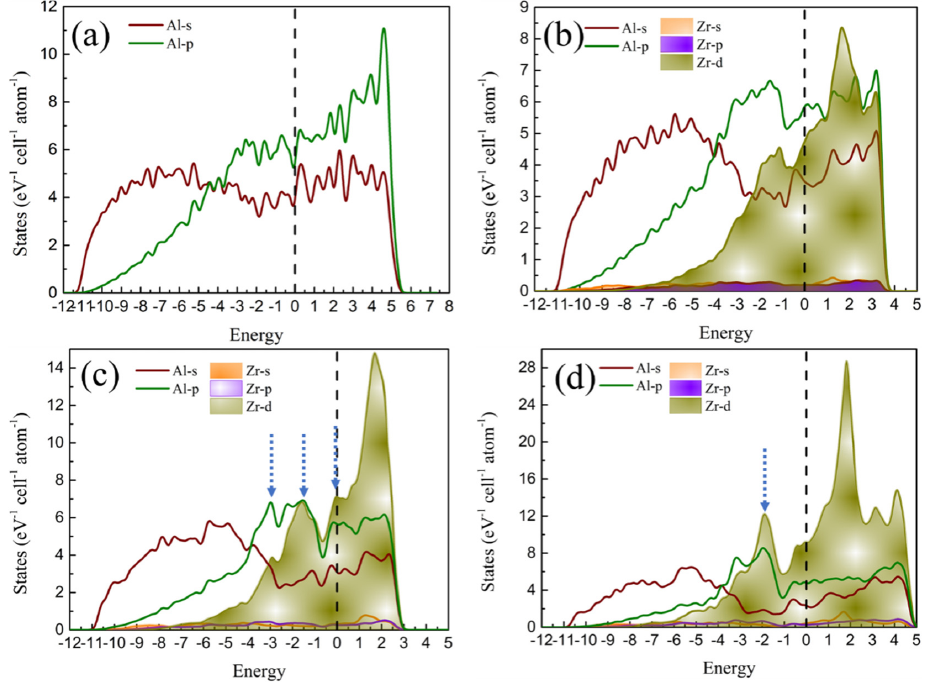
Figure 9. The projected density of state (PDOS) of the solute atoms Zr and surrounding host atoms Al. ( a ) The host Al atoms for the pure Al, ( b ) the solute atoms Zr and surrounding host Al atoms for the Al supercells with the chemical short ‐ range ordering clusters L1 2 ‐ Al 3 Zr of the volume fraction of 1/27, ( c ) the solute atoms Zr and nearest host Al atoms for the Al supercells with the chemical short ‐ range ordering clusters L1 2 ‐ Al 3 Zr of the volume fraction of 3/27 and ( d ) the solute atoms Zr and nearest host Al atoms for the Al supercells with the chemical short ‐ range ordering clusters L1 2 ‐ Al 3 Zr of the volume fraction of 9/27. The Fermi level is set as zero (the Fermi level is presented by the vertical dashed line). 4. Conclusions In conclusion, in the present work, the mechanical properties of the Al solid solution with varied compositions of the solute atoms Zr and the Al supercells with the chemical short ‐ range ordering structures L1 2 ‐ Al 3 Zr were evaluated using first ‐ principle calcula ‐ tions. Firstly, the supercells of the solid solution with varied compositions of the solute atoms Zr were constructed by using special quasirandom structures (SQSs). Next, the Al supercells with the chemical short ‐ range ordering structures L1 2 ‐ Al 3 Zr were obtained by substituting the Al atoms with the Zr atoms. Then, the bulk modulus B , shear modulus G , Young’s modulus E , Poisson’s ratio ν , hardness H and Pugh ratio B / G of the polycrystal were calculated to investigate the elastic property below a specific stress. Finally, the ideal tensile strength was investigated by conducting the first ‐ principles tensile test. In addi ‐ tion, the deformation charge density, electron localization function (ELF) and the pro ‐ jected density of state (PDOS) were computed to reveal the nature of the strengthening effects of the solid solutions and the chemical short ‐ range ordering structures L1 2 ‐ Al 3 Zr on the pure Al. The work of the separation W sep and the work of dislocation emission G disl were also calculated to reveal the competing fracture mechanisms. Here, the main find ‐ ings of this work are as follows: (1) The solid solutions with varied compositions of the solute atoms Zr and the chemical short ‐ range ordering clusters L1 2 ‐ Al 3 Zr can improve the strength of the pure Al. In particular, the chemical short ‐ range ordering clusters L1 2 ‐ Al 3 Zr of the volume frac ‐ tion of 3/27 can simultaneously improve the strength and ductility of the Al supercell. which is confirmed by the calculated elastic property such as Pugh ratio B / G and